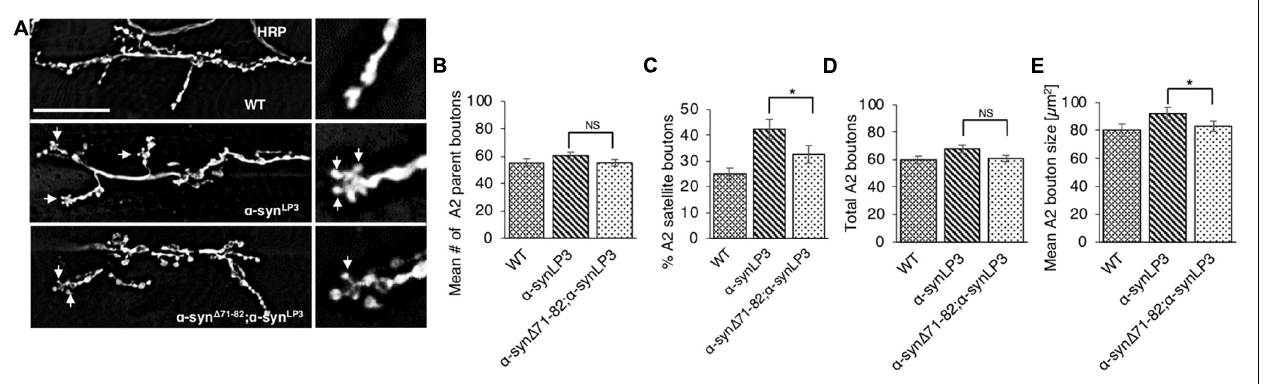
FIGURE 8 | Expression of α -syn lacking the NAC region rescues α -syn-mediated synaptic morphological defects within larval NMJs. (A) Larval segment A2 of muscle 6/7 from wild-type (WT) or α -syn LP3 larvae and larvae co-expressing α -syn LP3 ; α -syn (cid:49) 71 − 82 stained with the pre-synaptic marker horseradish peroxidase (HRP). Inset of enlarged images shows a single synaptic bouton with satellite boutons budding off (arrows). (B) Quantitative analysis of the mean number of parent bouton in α -syn LP3 ; α -syn (cid:49) 71 − 82 expressing larvae shows a decrease which is not significant compared to α -syn LP3 . (C) Quantitative analysis of the percent (%) of satellite boutons in α -syn LP3 ; α -syn (cid:49) 71 − 82 larvae shows a significant decrease compared to α -syn LP3 ( p < 0.001). (D) Quantification of the total number of boutons, which include both parent and satellite boutons, shows a decrease in α -syn LP3 ; α -syn (cid:49) 71 − 82 compared to α -syn LP3 which is similar to WT. (E) Mean bouton area from α -syn LP3 ; α -syn (cid:49) 71 − 82 shows a significant decrease compared to α -syn LP3 which is similar to the WT control. Quantitative analysis represents mean ± SEM. ∗ p < 0.05, NS = not significant, n = 5. Bar = 25 µ